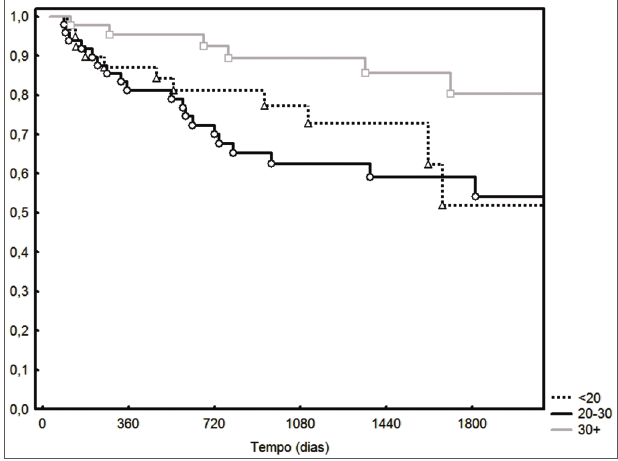
Figura 2. Número de linfonodos de acordo com o estádio N ( p =0,08).